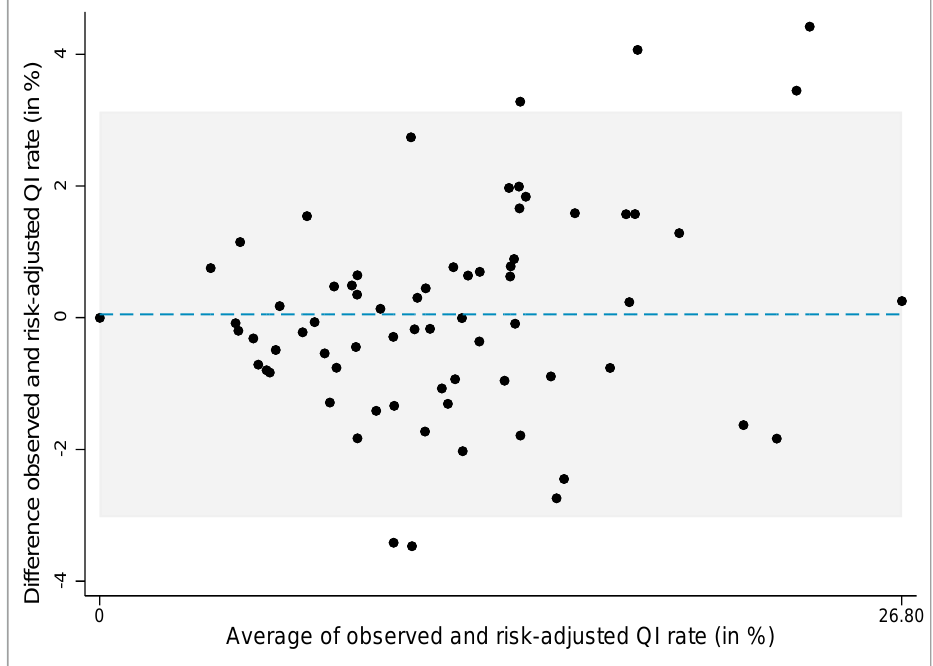
Figure 2. Bland-Altman plot of differences between the observed and risk-adjusted quality indicator rates. The dashed blue horizontal line shows the mean difference (0.05). The grey shaded area depicts the 95% agreement interval ( − 3.028 to 3.127). 8.57% (6/70 values) lies outside the limits of the agreement. The averages of observed and risk-adjusted QI rates lie between 0.0% and 26.8%.